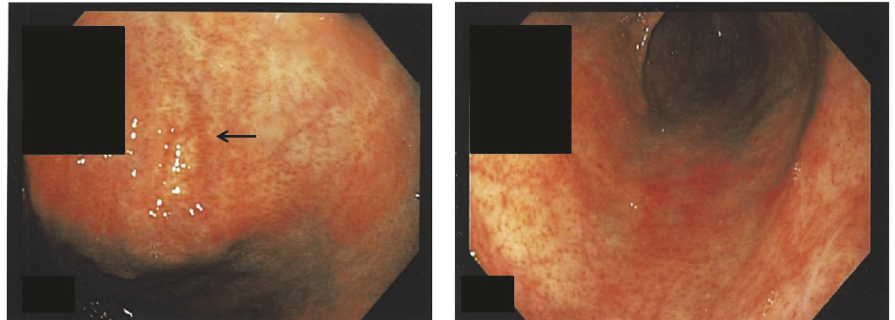
Figure 4: Endoscopic photos of the body of the stomach 7 weeks after cessation of olmesartan show atrophic mucosa with few residual areas of erythema (arrow) and complete resolution of the